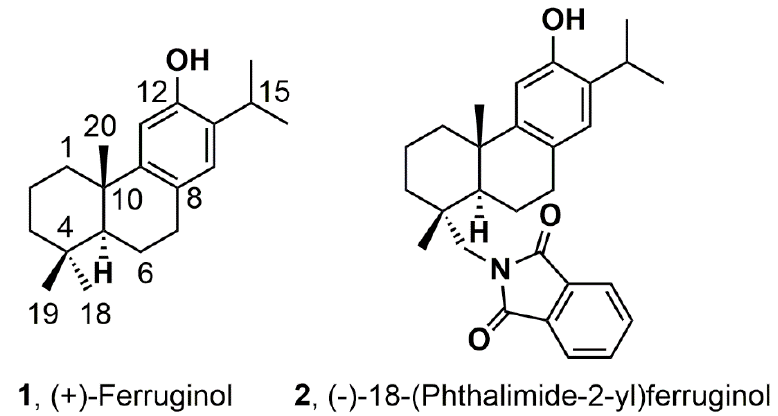
Figure 1. Antiviral abietane diterpenoids 1 and 2 and carbon skeleton numbering.